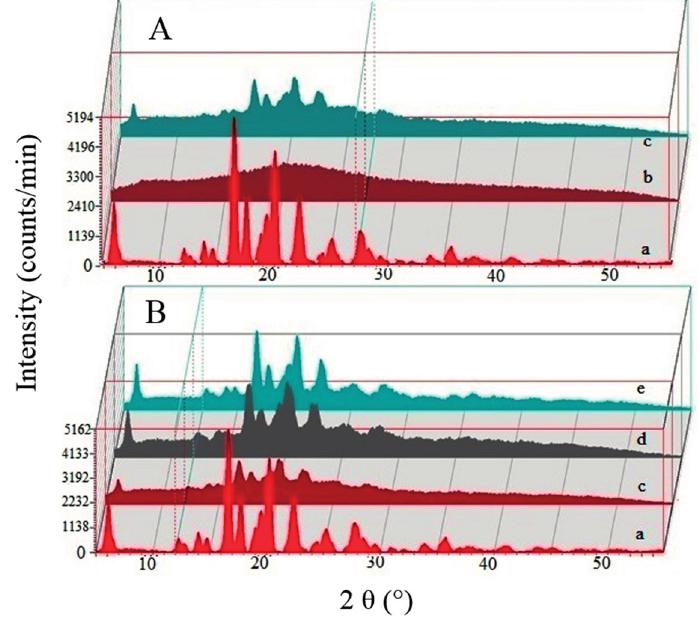
Figure 3. X-ray diffractograms of micronized ibuprofen (a), unloaded (b), 30 (c), 45 (d)